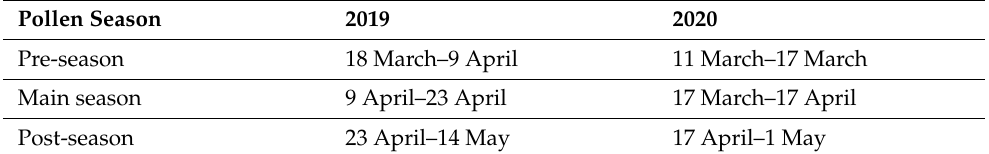
Table 2. Classification of pollen seasons for the seed plantation Emmendingen in 2019 and 2020. Pollen